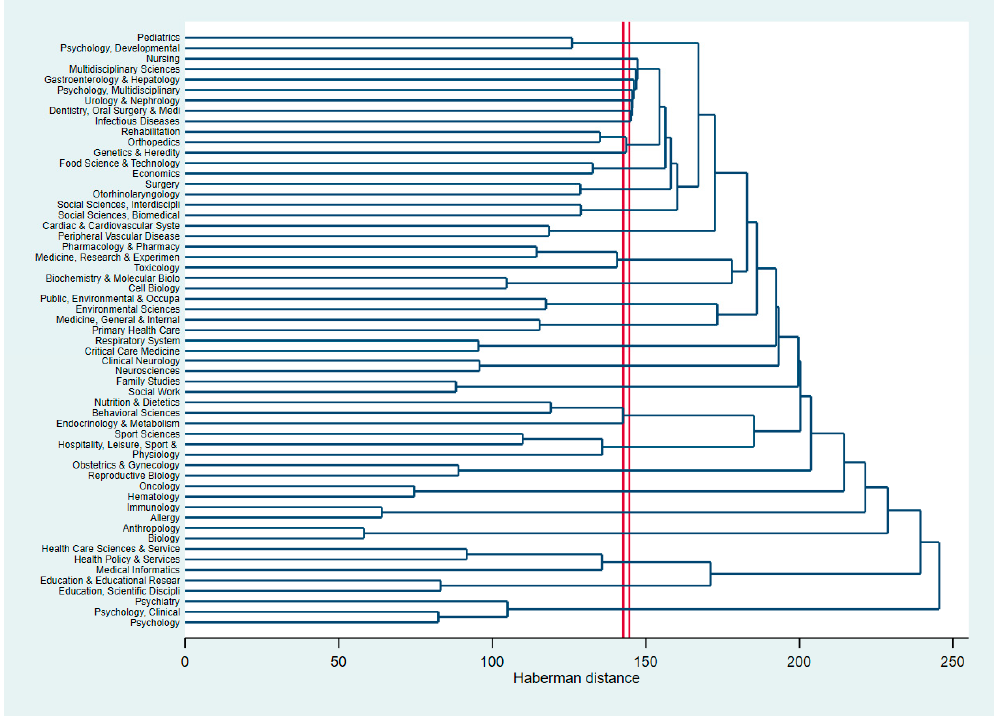
Figure 2. Dendrogram of coincidence of research areas using the WOS classifications.